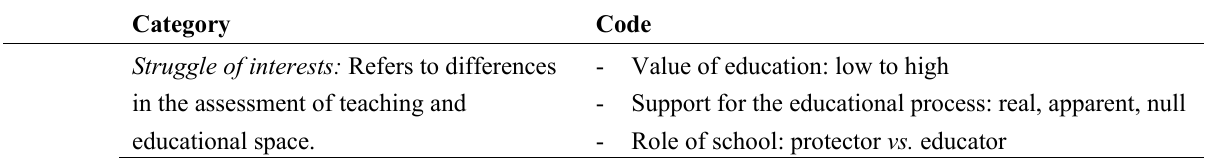
Table 4. Aspects associated with the conflict between the school and immigrant